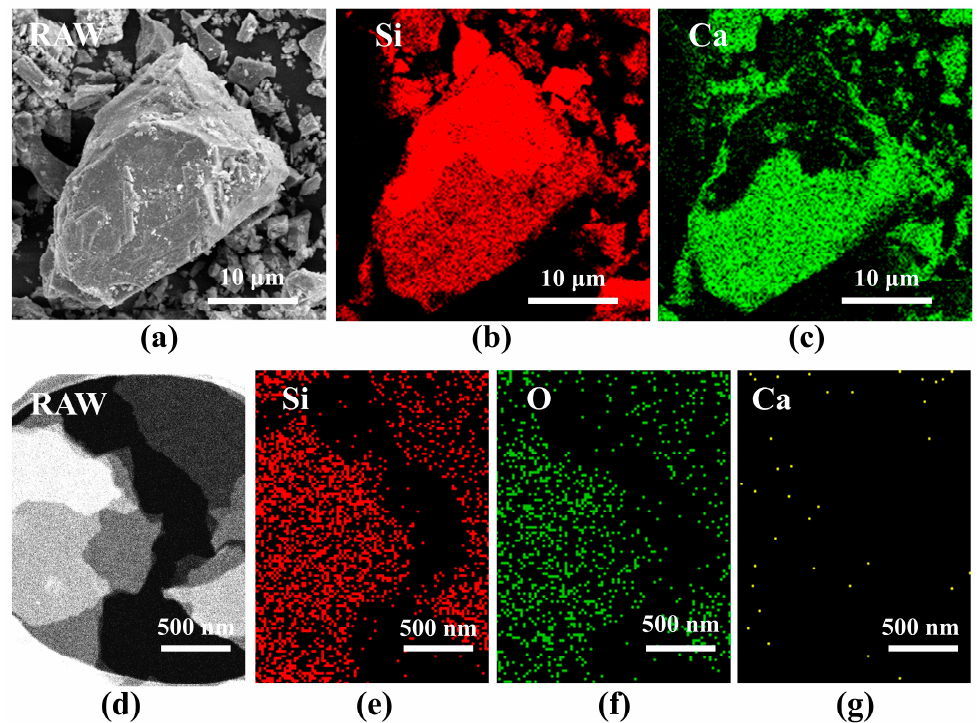
Figure 1. Microscopic morphology of CaSi 2 powders and siloxene nanosheets. SEM image of CaSi 2